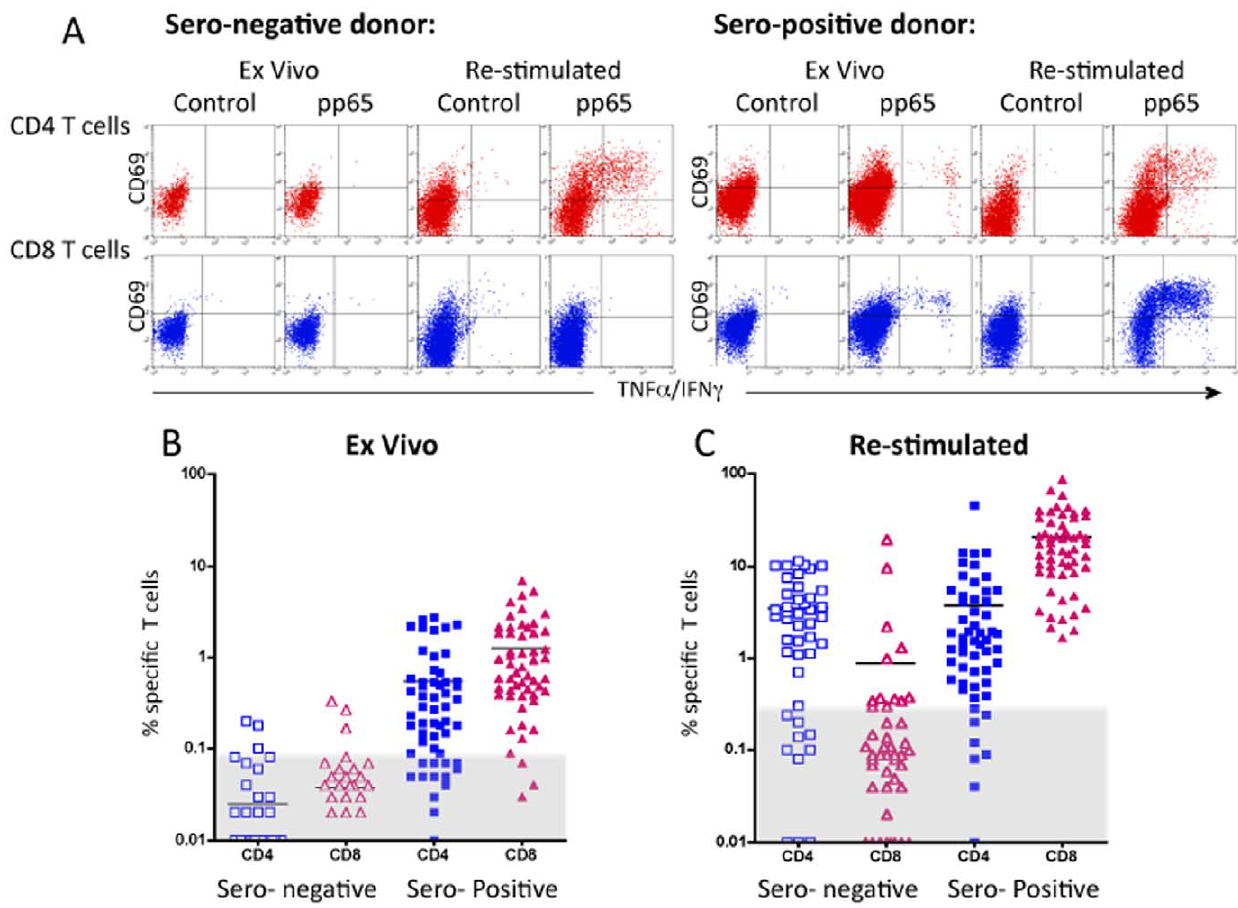
Figure 1. Detection of pp65 specific CD4 + and CD8 + T cell responses. PBMC from 100 healthy donors, 44 CMV seronegative and 56 seropositive, were analyzed either ex vivo or after in vitro stimulation with the pp65 peptide mixture for 7 days. The cells were examined for pp65 specific responses using the ICS assay and stained for CD4, CD8, CD69 and intracellular TNF a and IFN c collectively. Background activation obtained in the absence of peptide was subtracted from the results obtained with the peptide mixture. In A) is shown examples of the ICS analysis of CD4 and CD8 T cell responses measures ex vivo and after stimulation of both a seropositive and a seronegative donor. In B) the ex vivo measured frequency of pp65 specific CD4 and CD8 T cells is shown for each seronegative and seropositive donor, respectively. In C) the frequency of pp65 specific CD4 + and CD8 + T cells measured after in vitro stimulation is shown for each seronegative and seropositive donor, respectively. After in vitro stimulation, the background activation was slightly higher than observed ex vivo ; positive responses were defined as frequencies . 0.09% for the ex vivo analysis, and as frequencies . 0.3% for the in vitro stimulation analysis. Background frequencies have been subtracted the specific frequencies and responses above 0.09% for the ex vivo analysis and 0.3% for the in vitro analysis were considered positive. Shown as the responses above the grey areas.